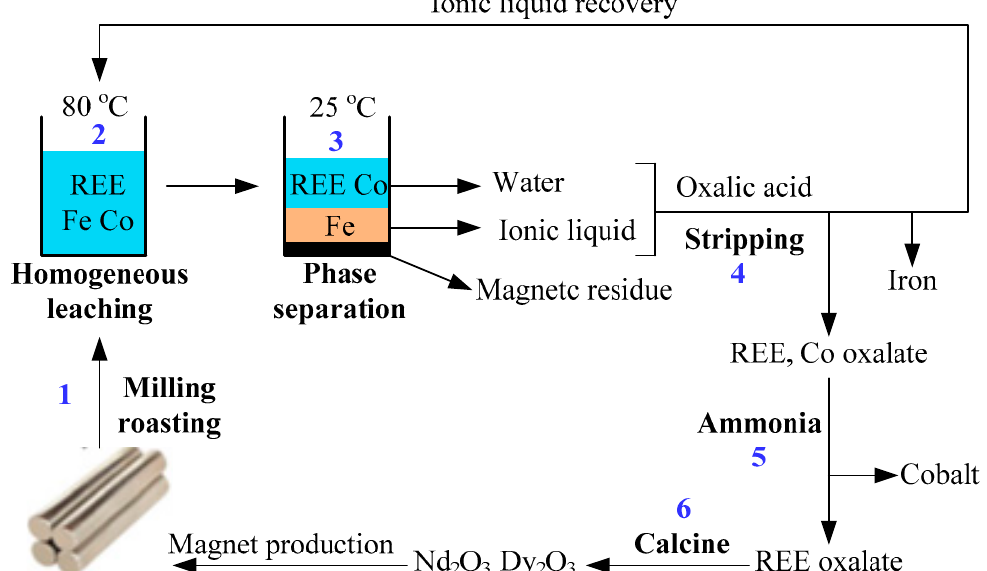
Figure 19. Overview of the proposed recycling process for roasted NdFeB magnets [36]; published by Royal Society of Chemistry, 2015.